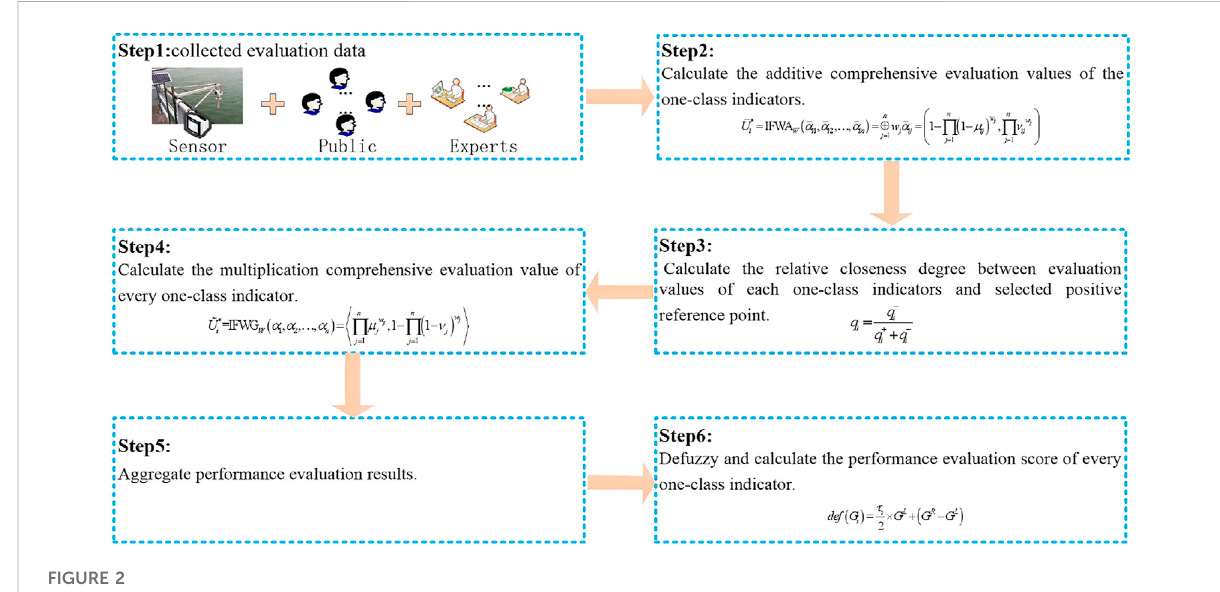
FIGURE 2 Procedure of the performance evaluation in